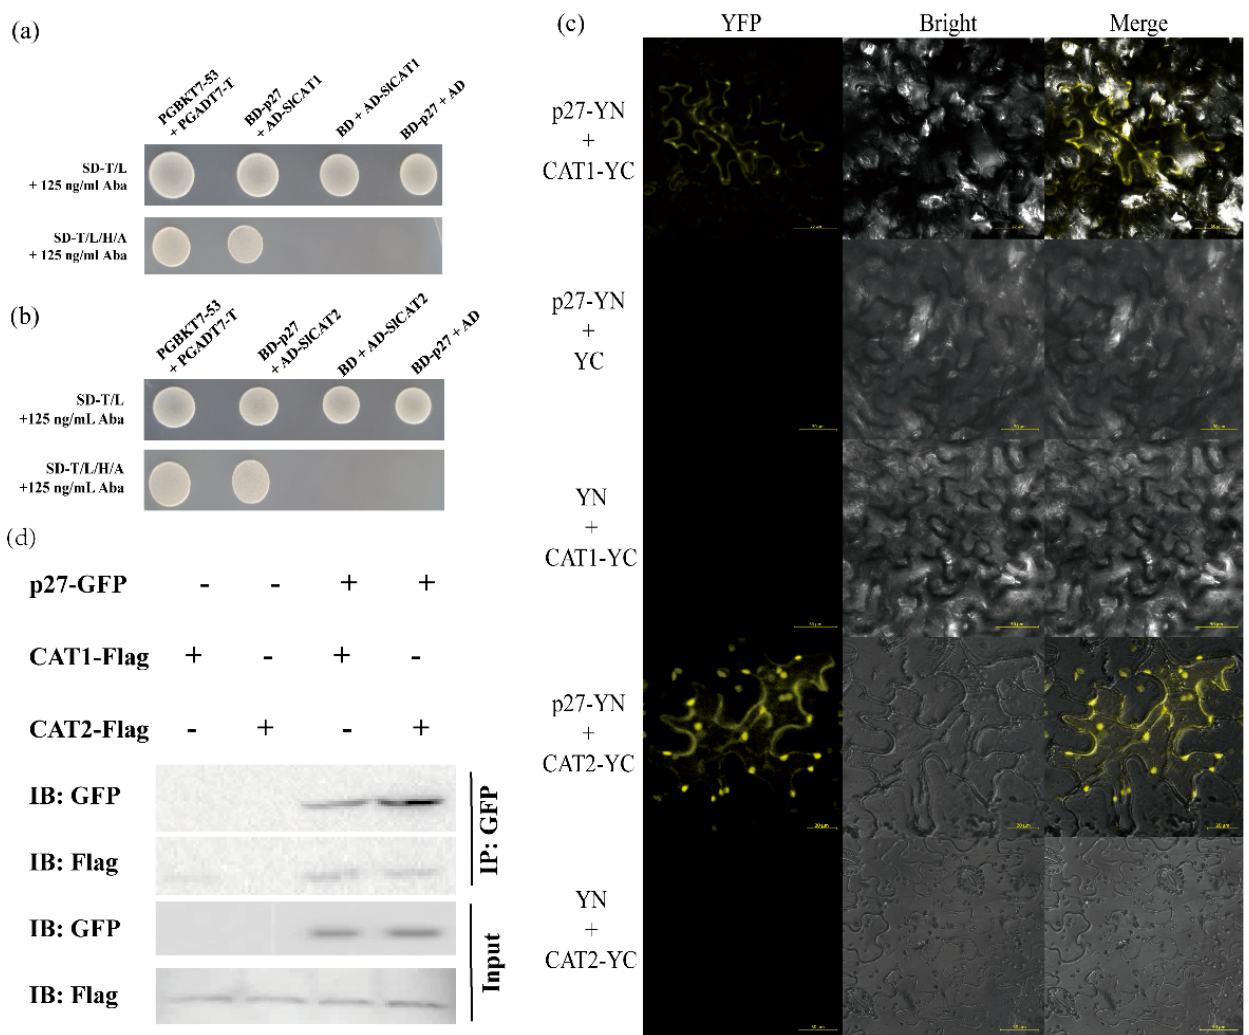
Figure 3. ToCV p27 interacts with itself and with SlCAT1 and SlCAT2. ( a ) Y2H verified the interaction of ToCV p27 with SlCAT1. ( b ) Y2H verified the interaction of ToCV p27 with SlCAT2. ( c ) BiFC verification shows that ToCV p27 interacts with SlCAT1 and SlCAT2. ( d ) Co-IP verified that ToCV p27 interacts with SlCAT1 and SlCAT2.